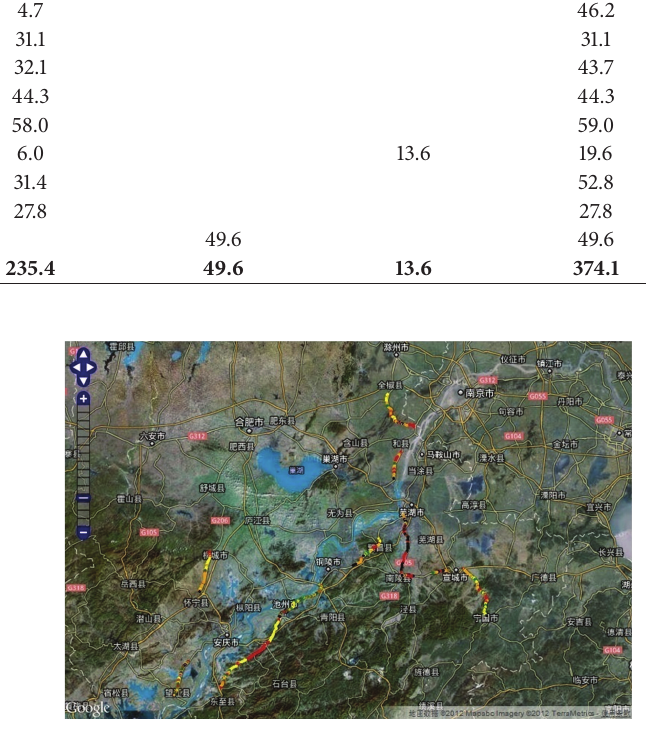
Figure 2: RIOH predicted accident rate decreasing map.